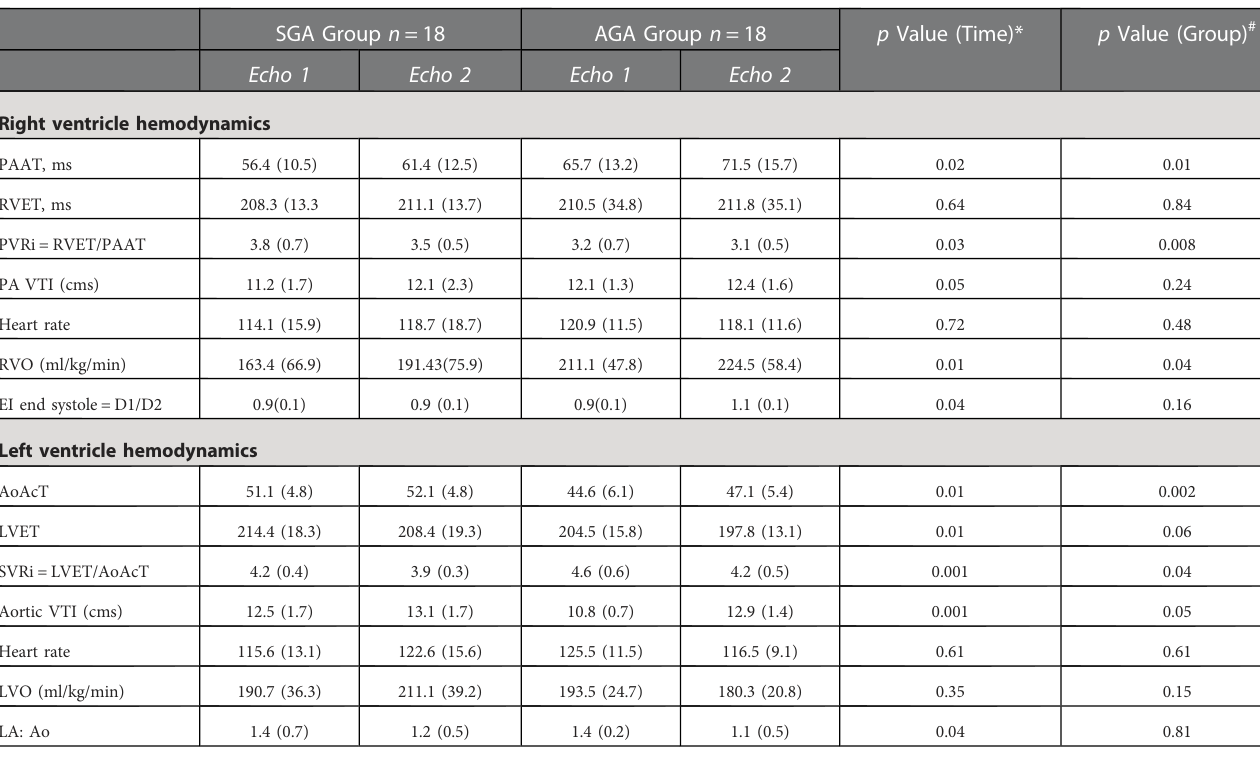
TABLE 5 Effect of group and time on pulmonary and systemic hemodynamics.